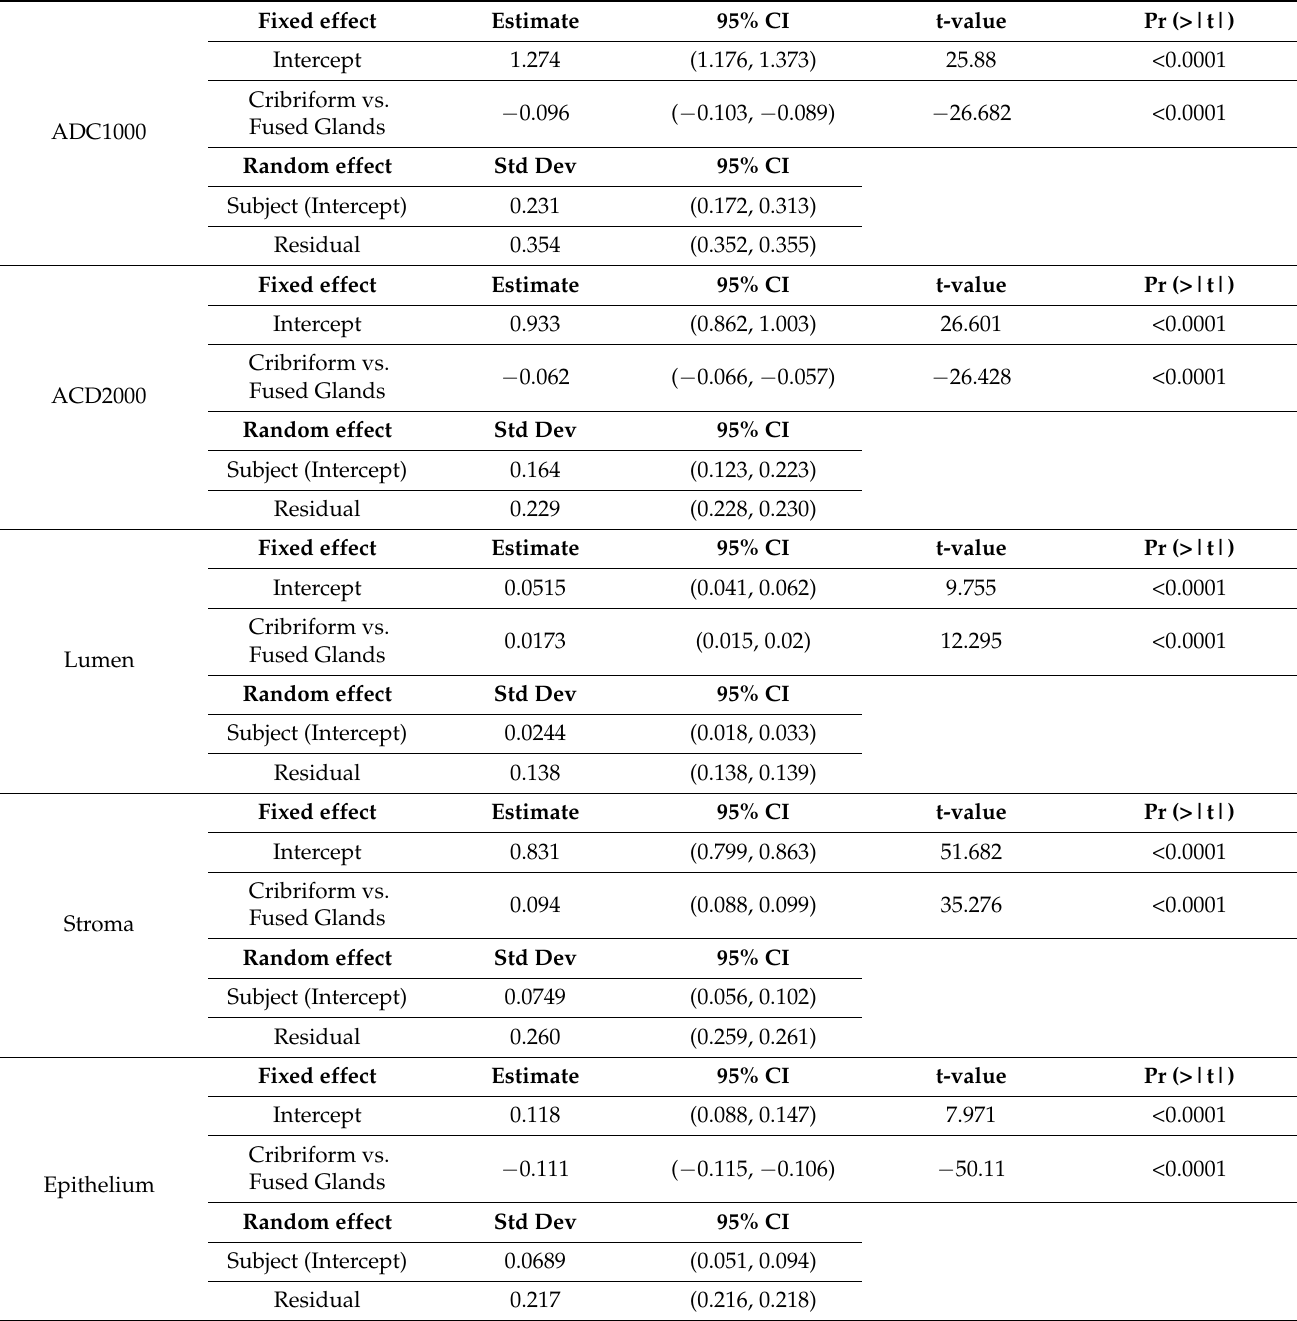
Table 2. One-Layer LMM considering patient as random effect. Estimate and 95% Confidence Intervals given in units of mm 2